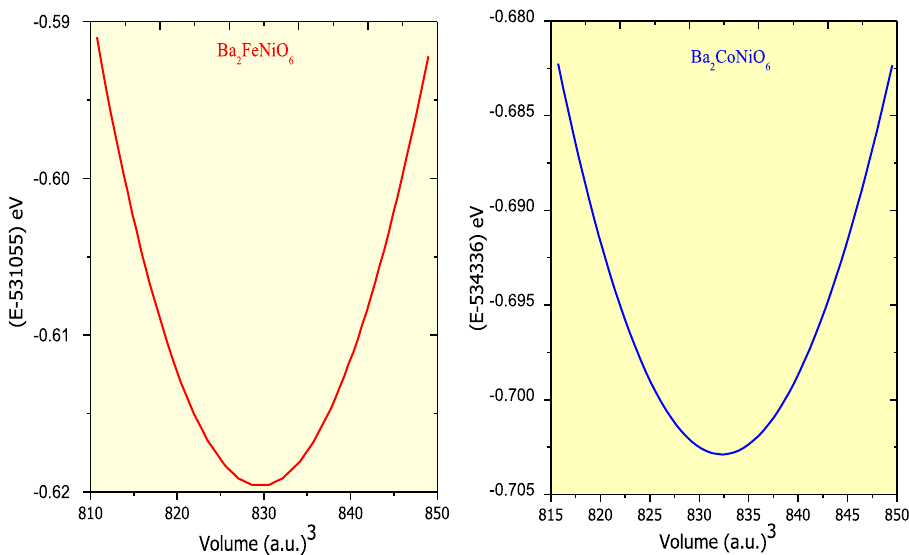
Figure 1. Total energy variation against volume (E-V plot) for Ba 2 BNiO 6 (B = Fe, Co) double perovskites in the ferromagnetic ordering. The minima in the E-V optimization curve correspond to the ground state energy, the equilibrium lattice parameters are evaluated corresponding to energy